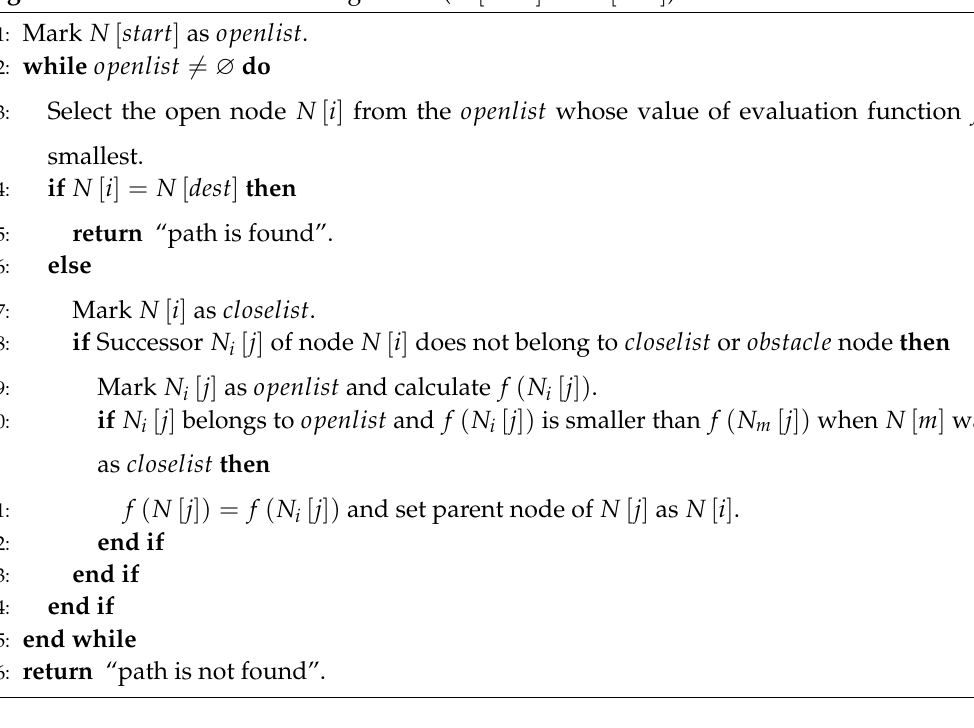
Algorithm 1 Traditional A-Star algorithm ( N [ start ] → N [ dest ]